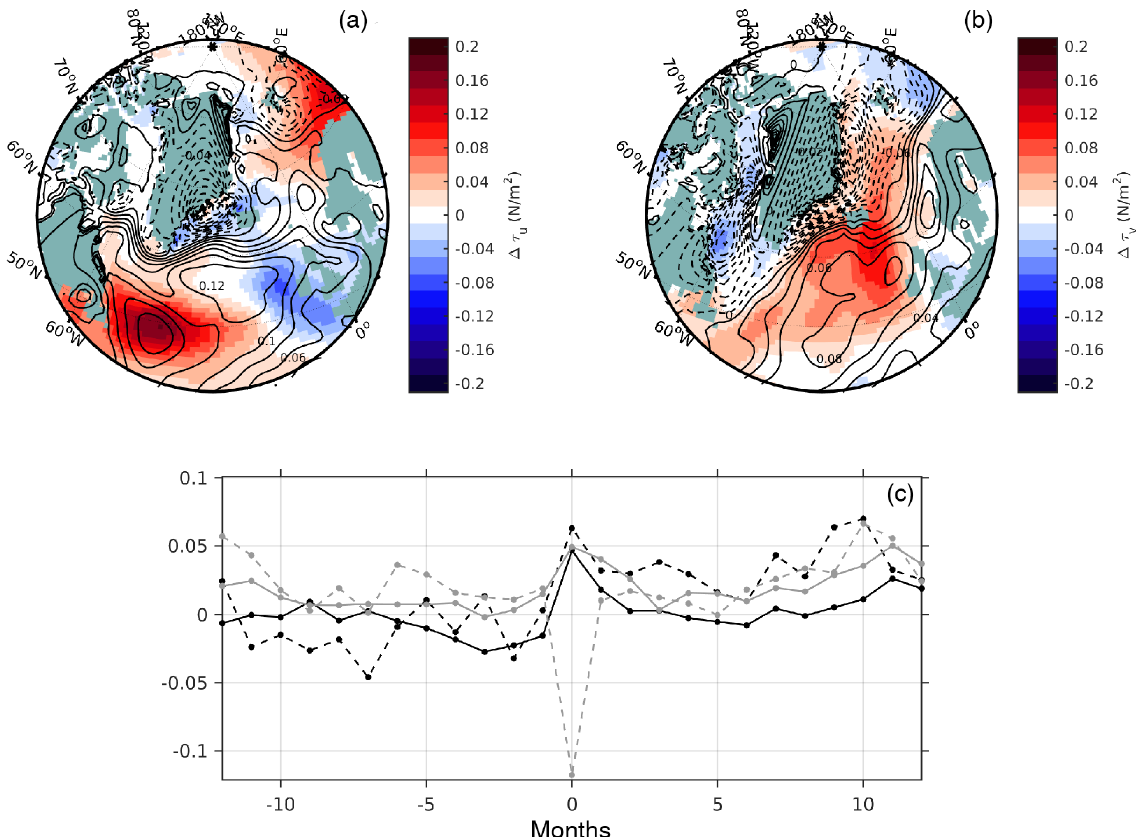
Figure 3. Winter (JFM) 2003 zonal (a) and meridional (b) wind-stress anomalies, respectively. Contours show the climatic winter average for the period 1996–2010. The panels show atmospheric NCEP reanalysis data (Kalnay et al., 1996) on the grid mask of the global ocean model. Lagged correlations in (c) are between modelled monthly mean IF-inflow anomalies for the Iceland (dashed) and Faroe (solid) components, respectively (Fig. 2). Results are calculated for zonal (black) and meridional (grey) wind-stress anomalies, respectively, on the ridge (approx. 64 ◦ N, 11 ◦